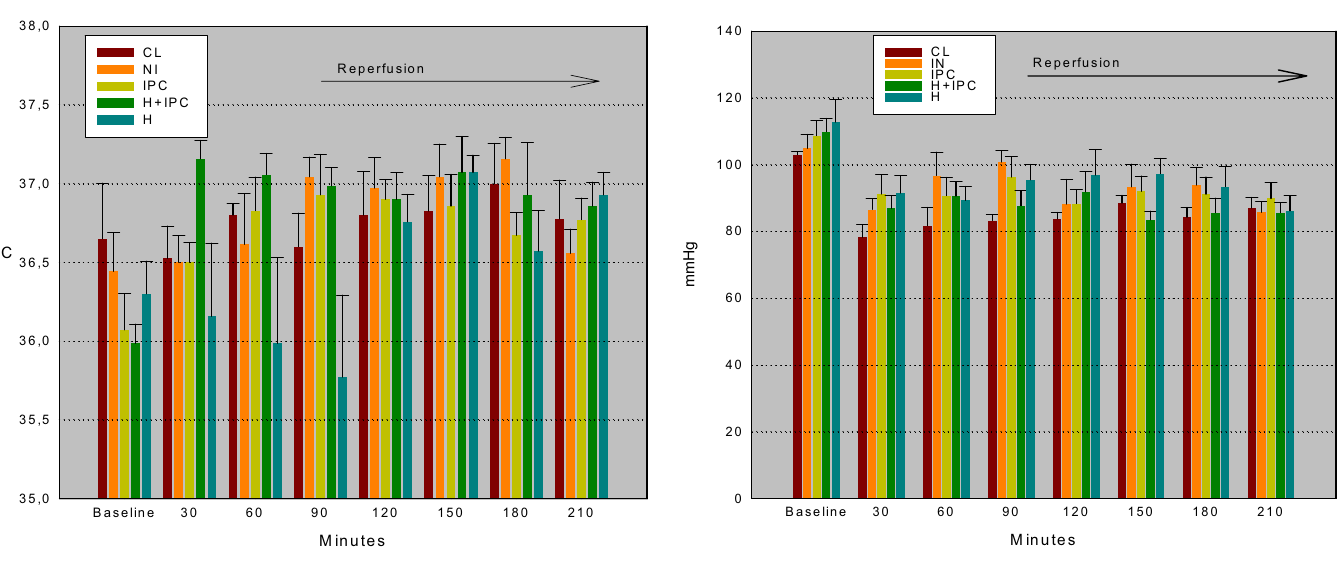
FIGURE 3 - MAP means of each evaluation in all groups. Ischemia: 30-90 minutes. Reperfusion: 120-210 minutes. No significant differences between the